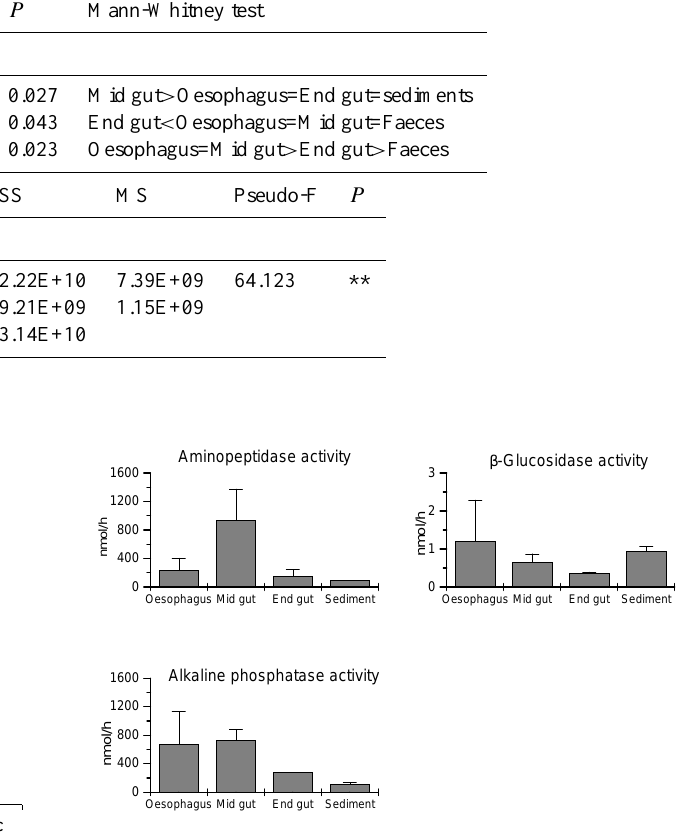
Fig. 5. Digestion rate in % of the main biochemical classes of organic compounds (proteins, carbohydrates, lipids) and biopoly- meric C in M. musculus . Standard deviations are indicated. Data are mg per g of sediment dry weight ( n = 3).